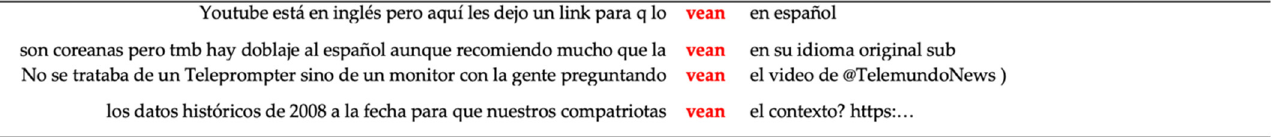
5 This means that we investigated not only the infinitive “hablar” (“to speak”) itself but also all conjugated forms of this verb.